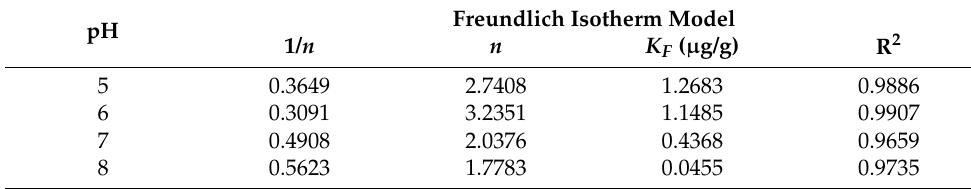
Table 3. Constants of Freundlich isotherm model for Cr(VI) adsorption on COC-AC-La. Freundlich Isotherm Model pH 1/ n n K F ( µ g/g) R 2 5 0.3649 2.7408 1.2683 0.9886 0.3091